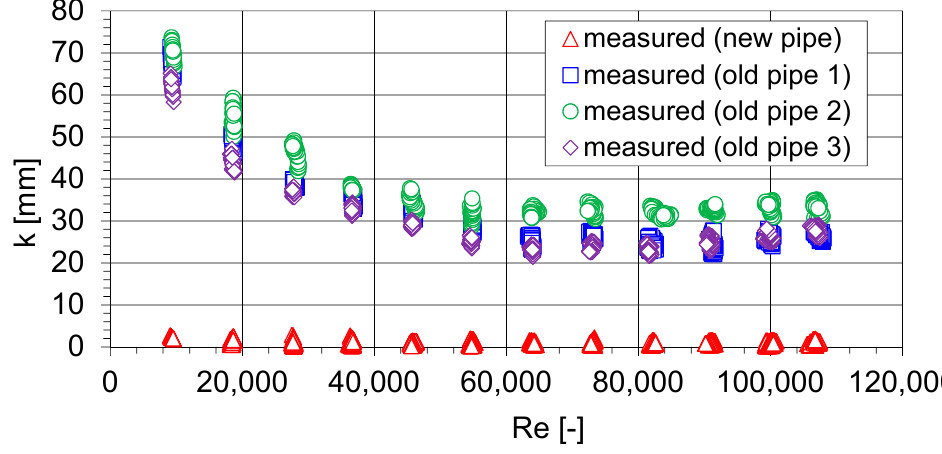
Figure 4. Absolute roughness k of the internal walls of the cast-iron pipelines with the internal diameter d = 150 mm, calculated according to Formula (8) for the new pipe and pipes after 30-year exploitation.